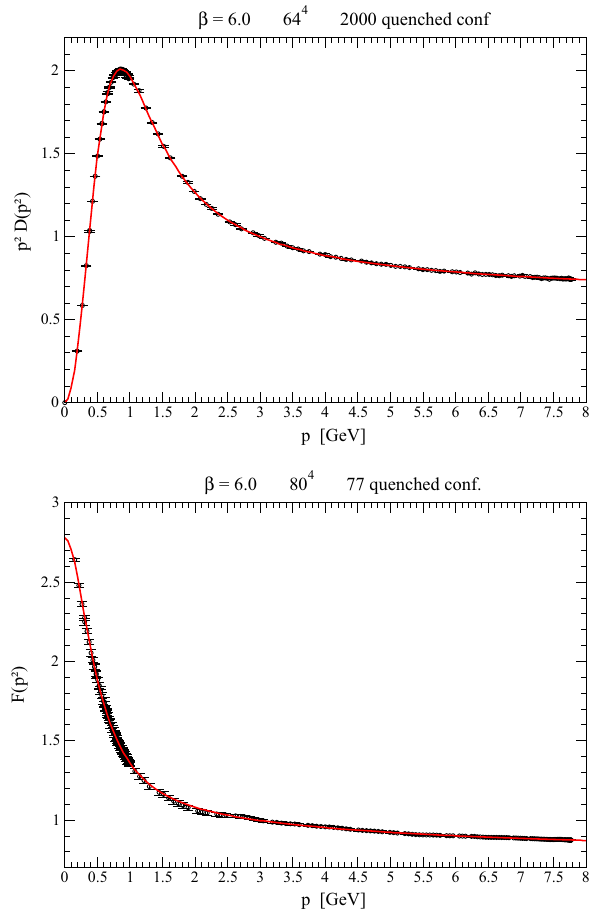
Fig. 4 PureYang–Millsgluon(top)andghost(bottom)latticedressing functions and the corresponding fit functions used herein. See text for details scale μ = 3 GeV and the fit associated to Eq. (63) can be seen on the top part of Fig.